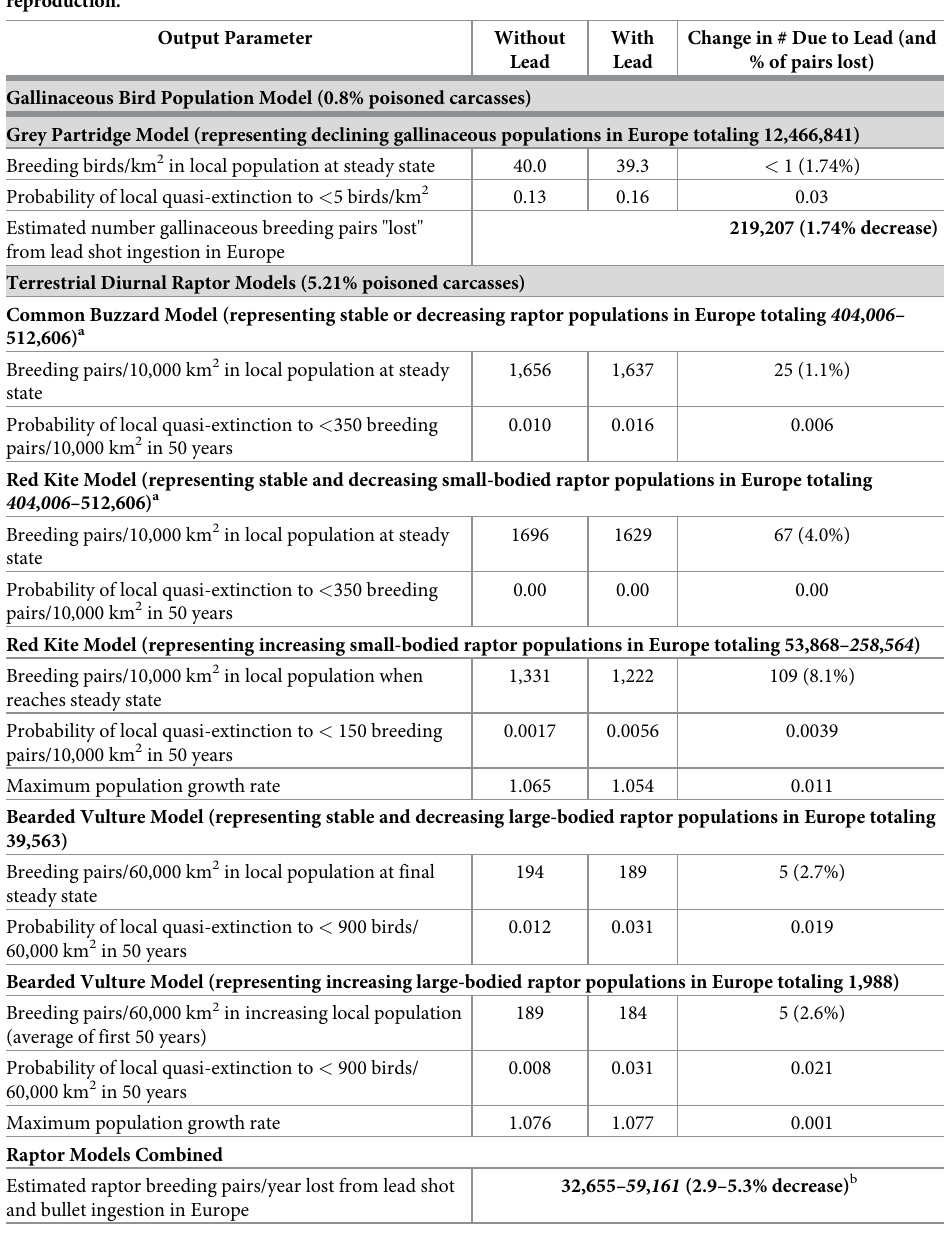
to detect in field evaluations. These reductions, based on Europe-wide estimates of impacts to small-bodied raptors, are assumed to be applicable to small-bodied raptor populations having the same population trend directions.